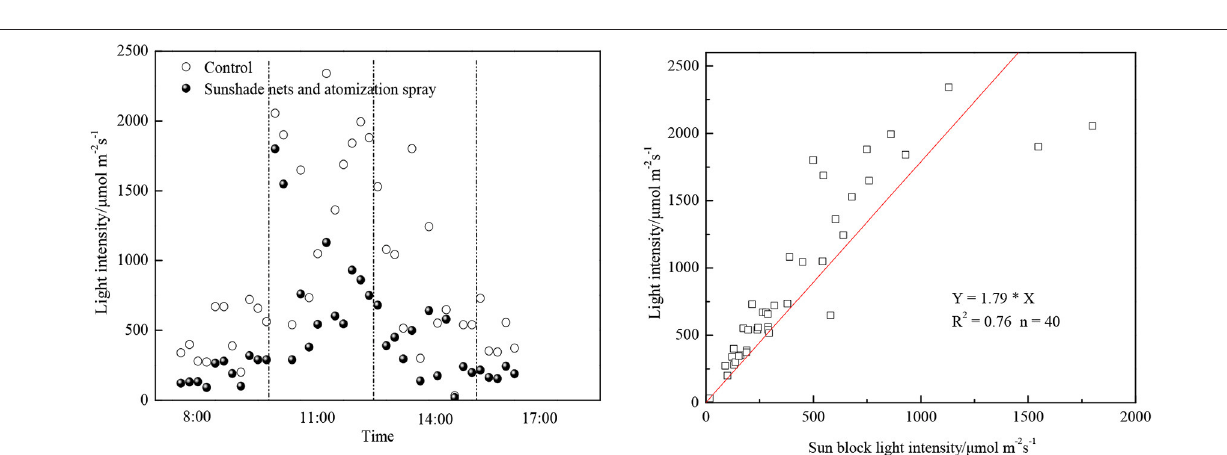
Frontiers in Energy Research |